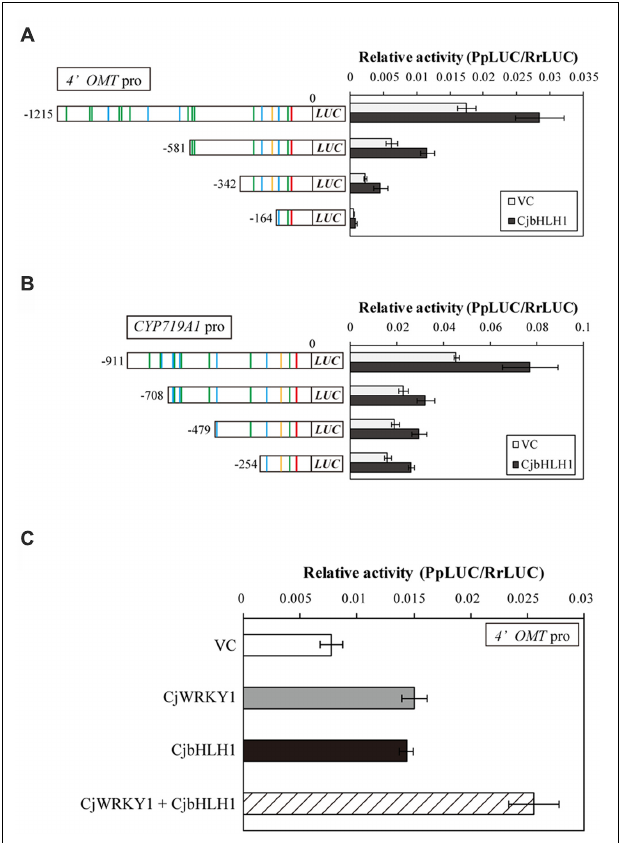
FIGURE 7 | Transactivation activity of CjbHLH1 in the truncated 4 (cid:48) OMT and CYP719A1 promoter:: LUC constructs in comparison with CjWRKY1. Transactivation activity of CjbHLH1 was measured with truncated 4 (cid:48) OMT (A) and CYP719A1 (B) promoter:: LUC constructs to evaluate